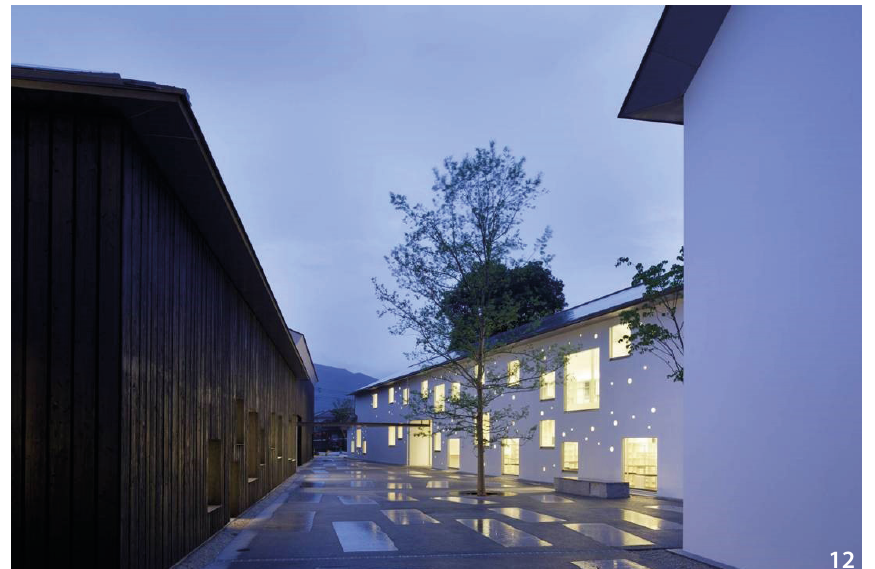
Figure 12 Makabe Denshokan at dusk 12 (Source: Satoru